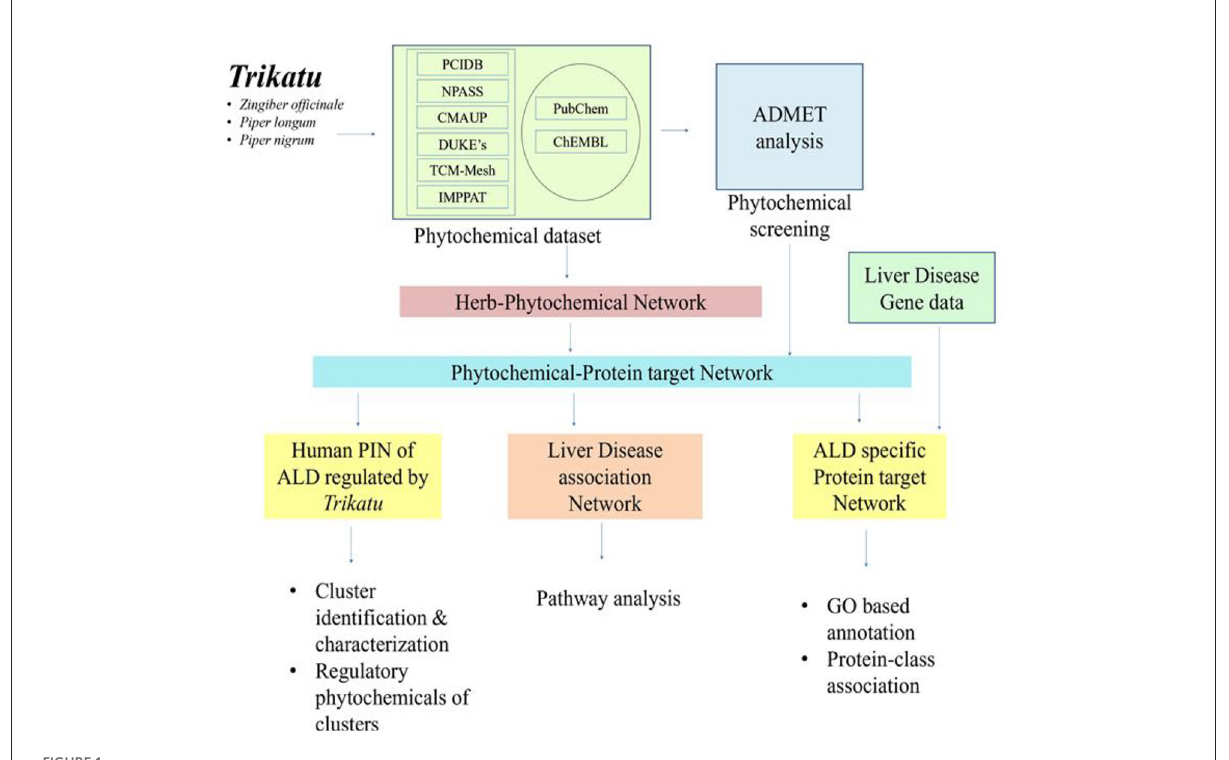
FIGURE1 Methodology of network